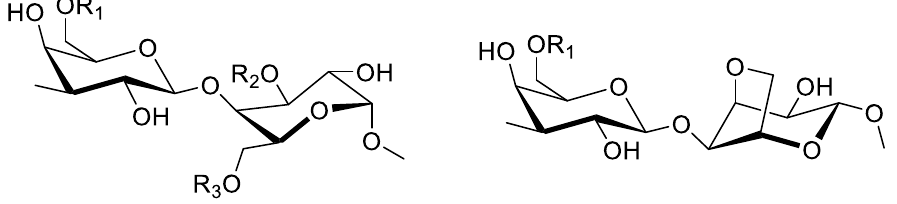
Gymnogongrus tenuis